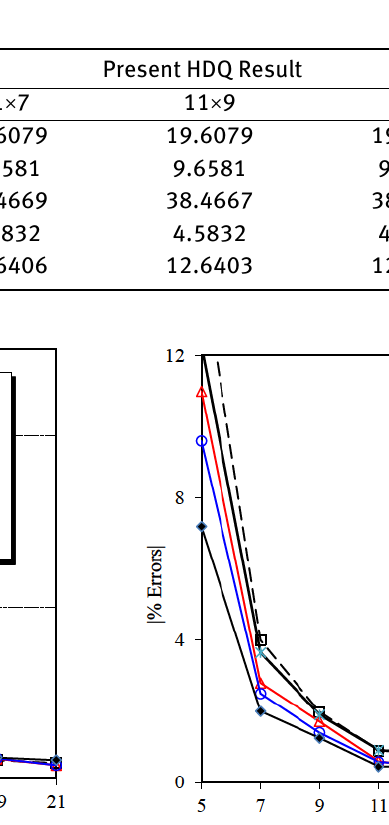
points in radial direction can yield accurate results for first four frequencies. The reason of discrepancy on the results is the different solution methodology. Shi et al. [101] used Rayleigh-Ritz method. To show on the convergence and accuracy of the DSC and DQ methods, a clamped-simply supported annular plate is investigated secondly. The ob- tained DQ and DSC results are listed in Table 2. To validate the present HDQ and DSC analysis based on the numeri- cal solution of the governing differential equations of an- nular plate, related equations have been solved for α = 90 and ϕ = 360. So, obtained frequency for different modes for C-S annular plates are compared with the results given by Tornabene et al. [56] in the literature, as shown in Ta-